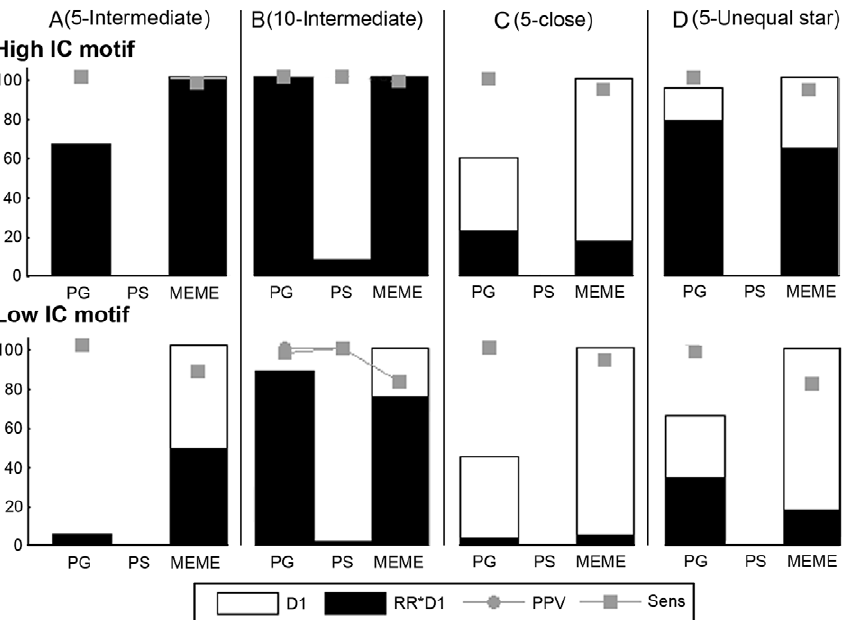
Figure 6. Results for motif detection in the orthologous space. Results are displayed for a synthetic dataset with motif sites sampled from a high IC (on top) and a low IC motif (below). Each dataset consists of only one reference gene and its orthologs, referred to as one orthologous set. Panel (A) and (B) represent the results when the orthologous set contains respectively five and ten prealigned orthologs related through an equal star topology with a proximity of 0.50. Panel (C) represents the results when the orthologous set contains five prealigned orthologs related through an equal star topology with a proximity of 0.90 and panel (D) represents the results when the orthologous set contains five prealigned orthologs related through an unequal star topology. Note that for most tests the PPV equaled the Sens resulting in overlapping dots. For the measures D1, RR*D1, PPV and Sens see Figure 2.